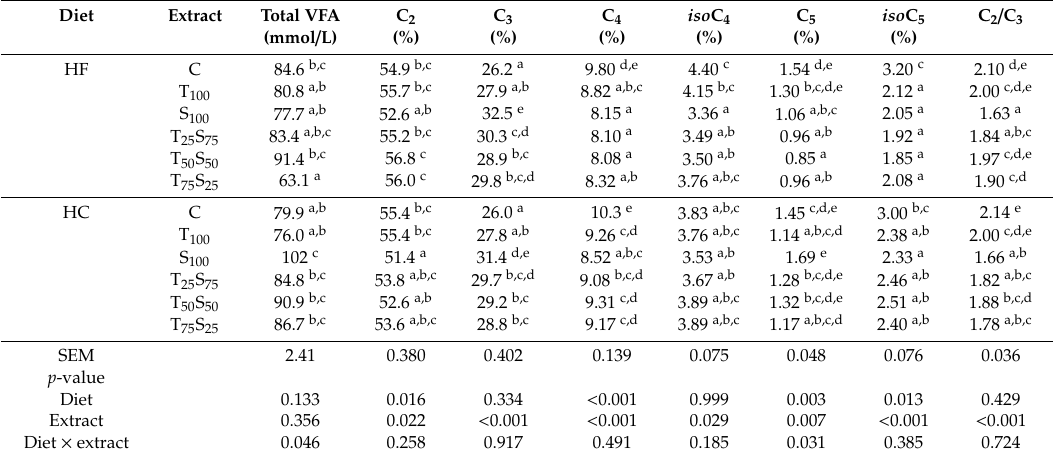
Table 4. Volatile fatty acid (VFA) profiles measured after 48 h of incubation of the HF or HC diets supplemented with varying proportions of plant extracts rich in T and